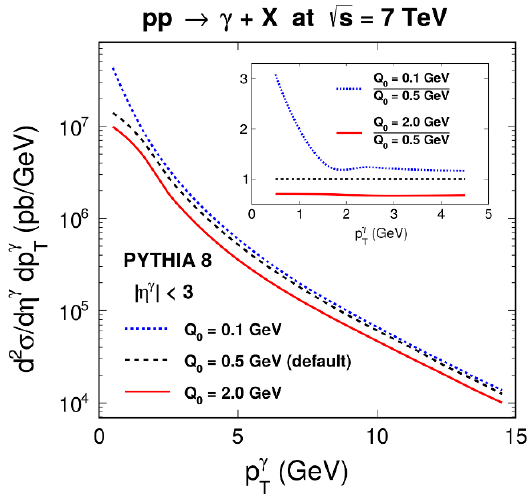
Figure 1 . Transverse momentum dependence of inclusive photons produced in pp collisions at the p LHC with a centre-of-mass energy of s = 7 TeV for di(cid:11)erent PS cut-o(cid:11) scales Q 0 in PYTHIA